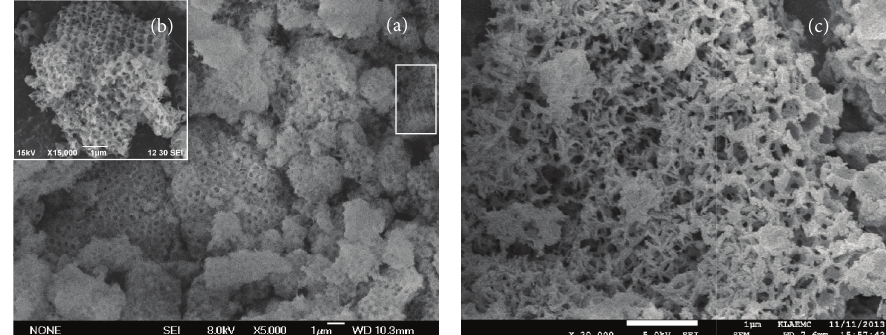
Figure 2: SEM images of 𝛼 -FeOOH and 𝛼 -Fe 2 O 3 -300 nanoparticles.